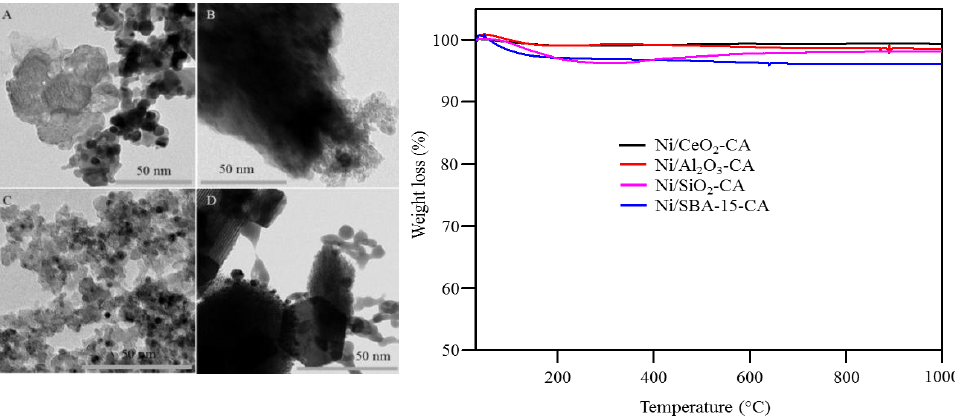
Figure 10. TEM images of different spent ( A ) Ni/CeO 2 -CA, ( B ) Ni/Al 2 O 3 -CA ( C ) Ni/SiO 2 -CA and ( D ) Ni/SBA-15-CA catalysts ( left ) and TGA results of different spent catalysts ( right ).